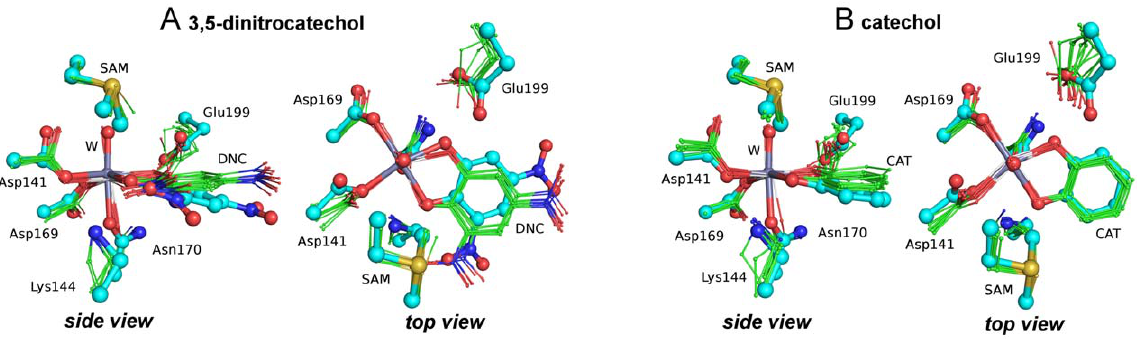
Figure 3. Comparison between the QM/DMD ensembles of active site structures (thin sticks, small spheres), and the X-ray structure (bold sticks, large spheres) for A) 3,5-dinitrocatechol, and B) catechol bound to the Mg(II) form of COMT. Hydrogen atoms, Met40, Lys46 and Asp205 are omitted for clarity.